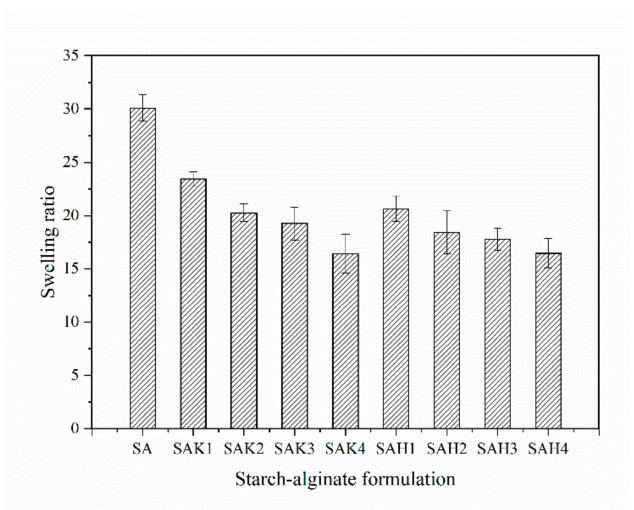
Figure 4. Swelling ratio of beads with di ff erent formulations in PBS at 30 ◦ C.